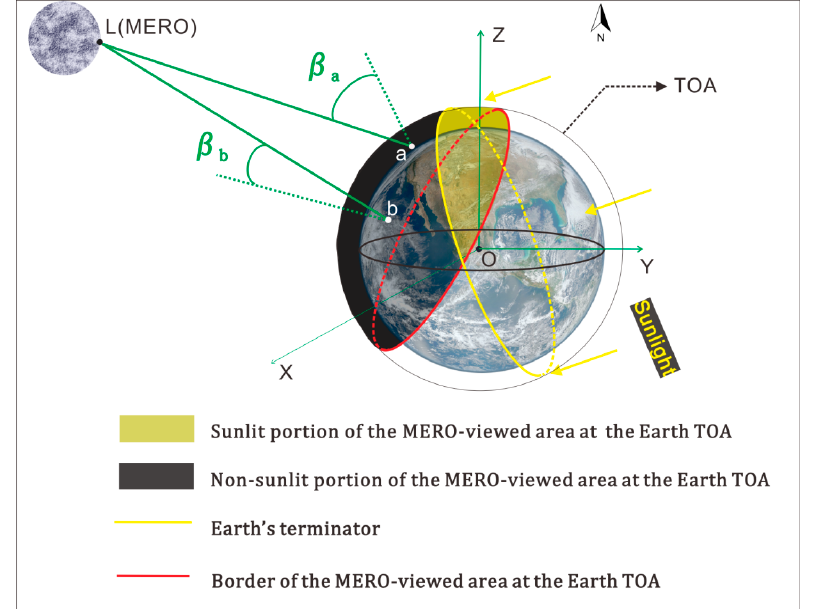
Figure 1. A sketch illustrating the sunlit and non-sunlit portions of the near-half-globe Moon-based Earth radiation observatory (MERO) viewed area at the Earth’s top of atmosphere (TOA), the location-varying viewing zenith angle 𝛽 and distance to the MERO.